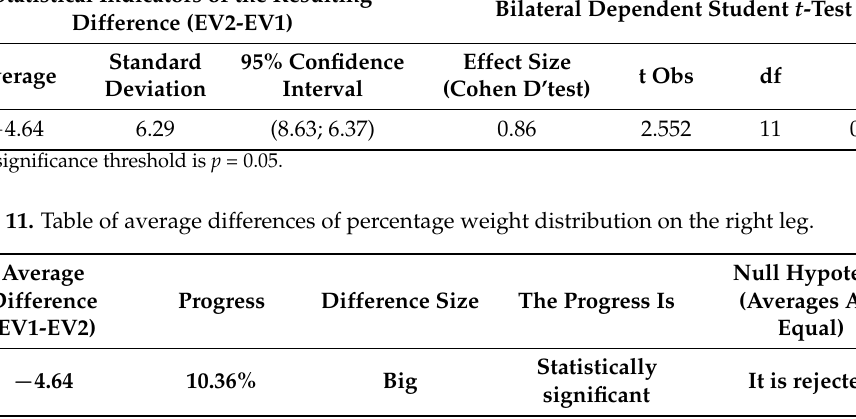
Figure 13. Percentage distribution of the weight on the right leg, from the total weight at the first and